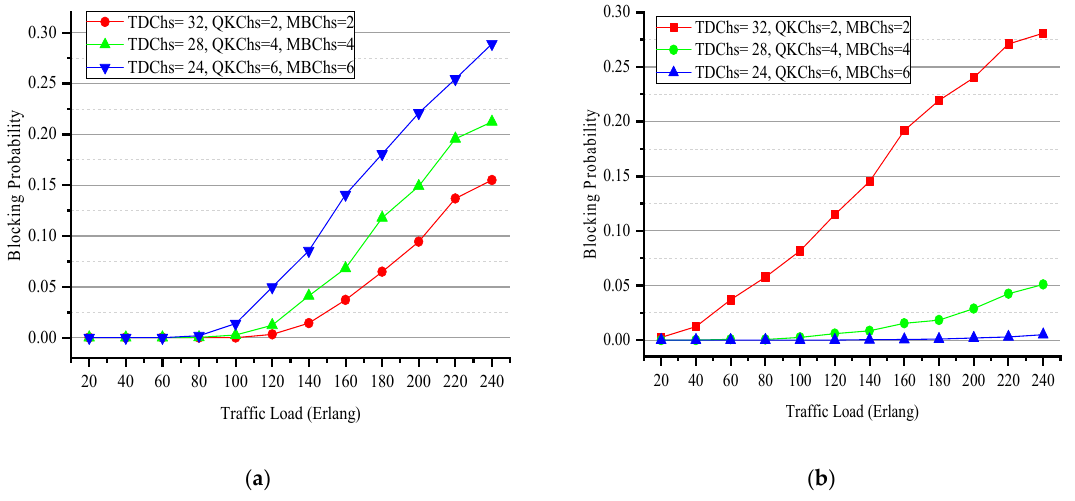
Figure 8. ( a )Blocking probability of TDCh vs. traffic load; ( b ) Blocking probability of QKCh vs. traffic